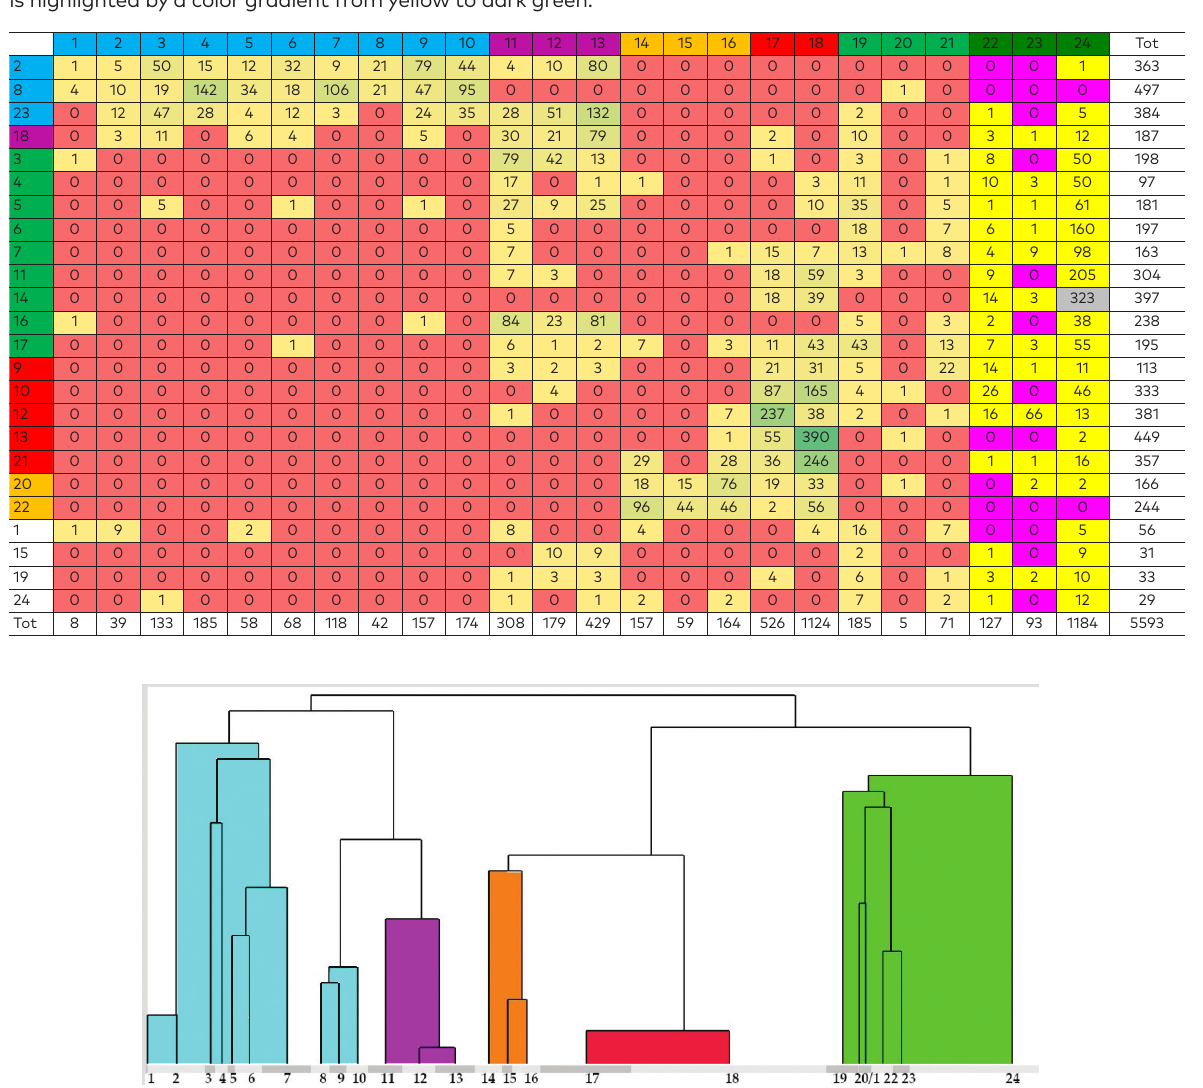
Figure 4. Modified TWINSPAN classification with 24 groups. Light blue color indicates groups belonging to